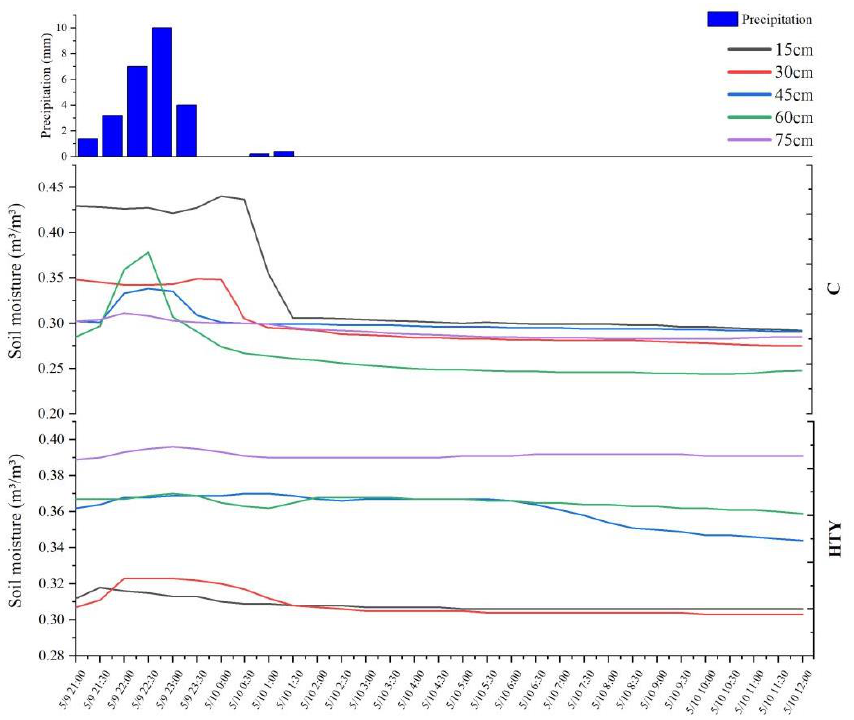
Figure 6. Response of soil moisture to precipitation in single rainfall.